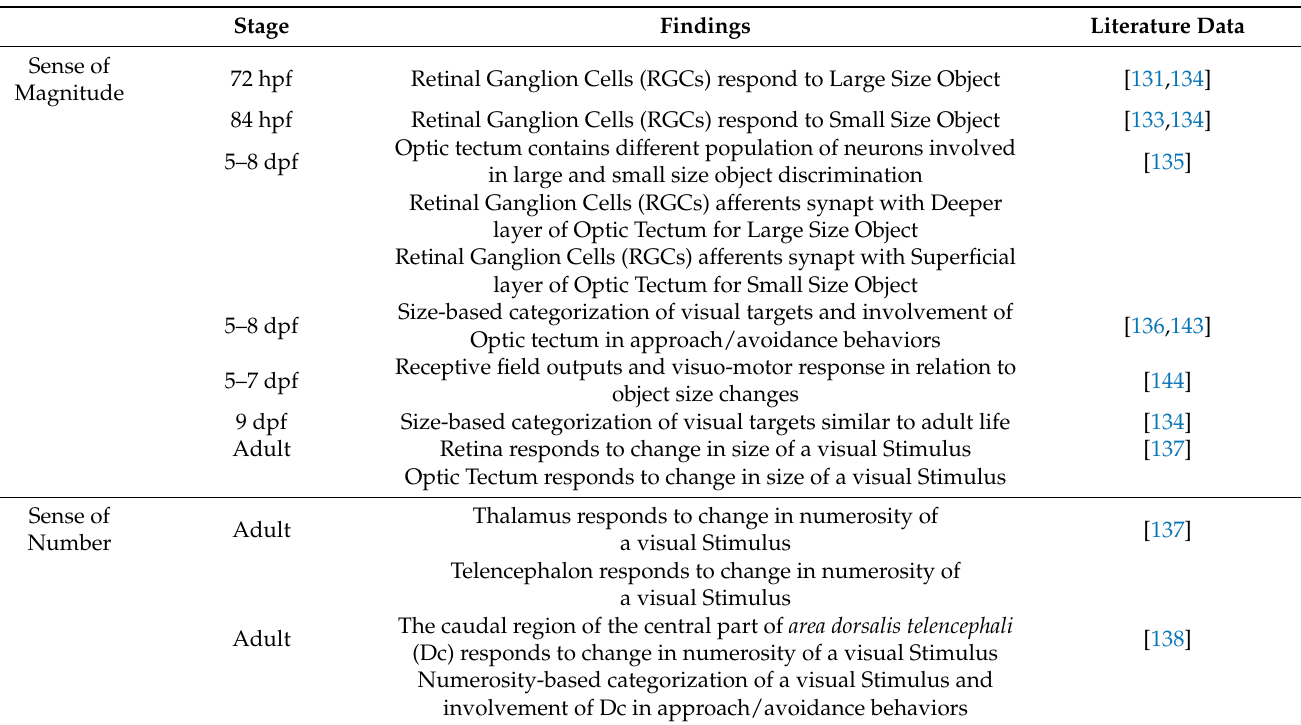
Table 1. Summary of the main findings connected to neural correlates of continuous and discrete quantity discrimination in